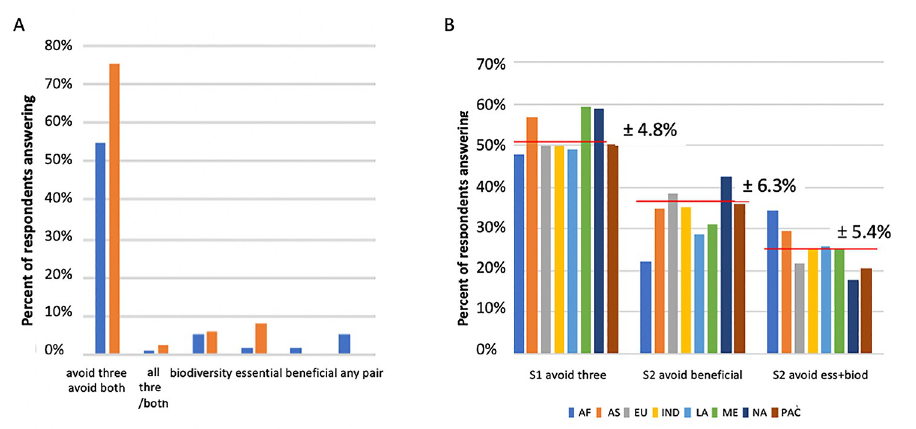
Fig 3. Results of the comparison of combination and avoidance of terms (beneficial, essential and diverse) to describe microbes. (A) Frequency in Survey 1 (blue) of the use of the words “beneficial”,”biodiversity” and “essential” in response to the question “Which words come to mind when you hear the word microbe” for survey 1 that also allowed respondents to answer “tiny”, “germ” and “disease”. Avoid three refers to Survey1/Question1 where respondents avoided all three positive terms (beneficial, biodiversity and essential). All three refers to the percent of respondents who used all three positive terms only in their answers. The frequency of similar answers to Survey 2/ Questions 1 and 2 are shown in orange. Biodiversity refers to the answer “There are many types of microbes” for Survey 2/Question1. Essential refers to the answer “Microbes are essential for life” for Survey 2/Question 1. Beneficial refers to the answer “Mostly beneficial” for Survey 2/Question 2. Avoid both refers to Survey 2/Question 1 where respondents answered both “There are many types of microbes” and “Microbes are essential for life” and both refers to respondents who gave those two answers to Survey 2/Question 1. (B) The left graph (S1 avoid three), refers to the percent of answers to Survey 1/Question 1 that avoided all three terms indicating positive aspects of microbes (beneficial, essential and diverse). The middle graph (S2 avoid beneficial), refers to the percent of answers to Survey 2/ Question 2 that avoided the term beneficial. The right graph (S2 avoid ess+biod), refers to the percent of answers to Survey 2/Question 1 that avoided the terms essential and biodiversity. For each panel, the red lines indicate the overall average and the standard deviation is shown. See https://sepakiosk.com/ for raw data.